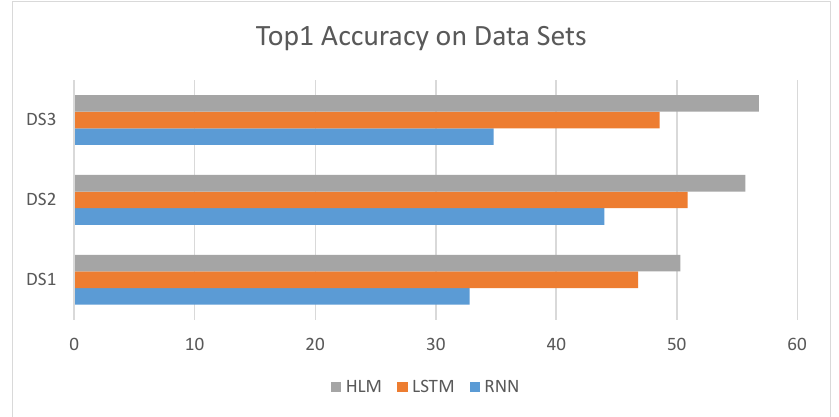
Figure 6. Top-1 accuracy for different models.